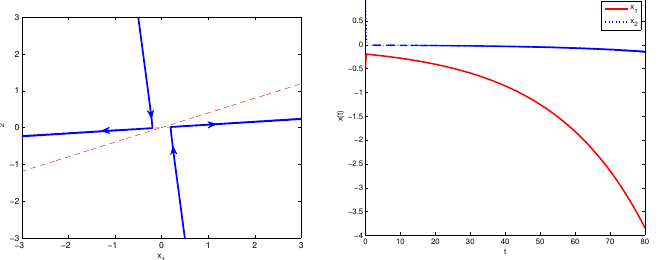
Figure 3. The unstable dynamics ( Left ) and unstable response curves ( Right ) of the system in Example